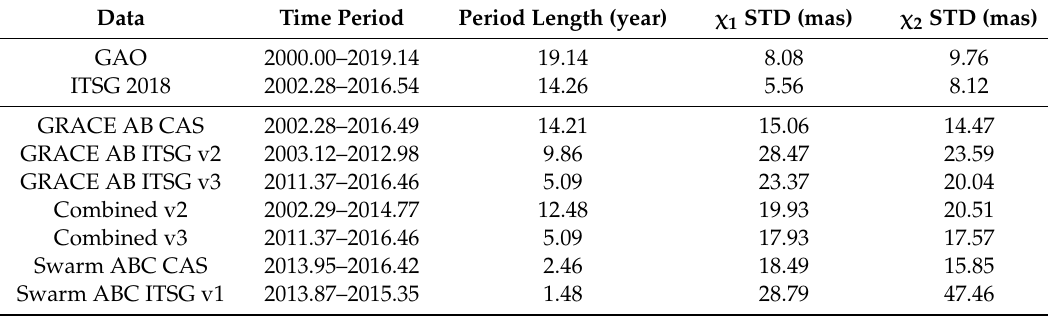
Table 4. Standard deviations (STDs) of χ 1 and χ 2 components of geodetic residuals (GAO) and di ff erent hydrological angular momentum (HAM) series. Note that series were available in di ff erent time periods (given in decimal years) and with di ff erent period lengths (given in